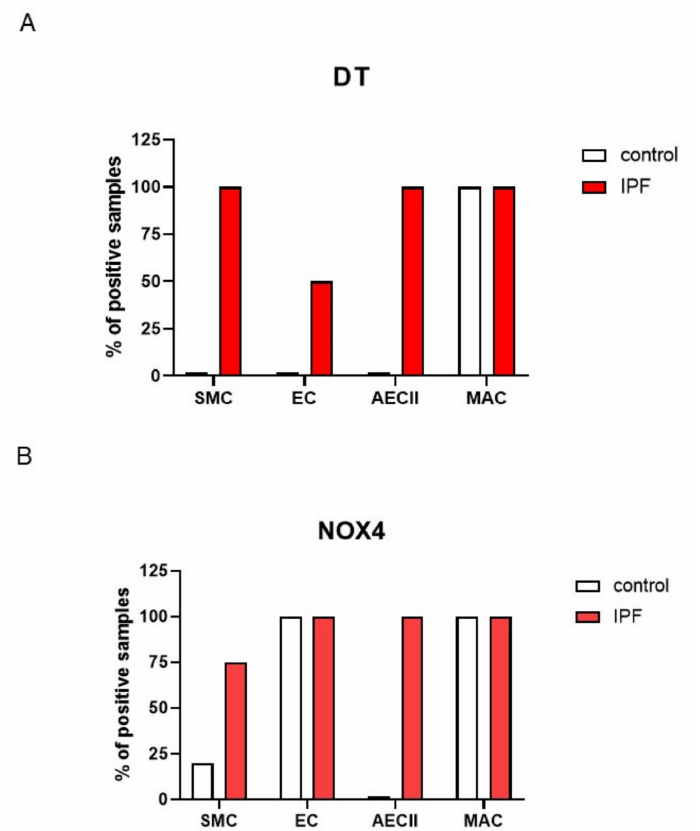
Figure 6. Histograms documenting the number of samples positive for DT and NOX4 for each cellular subtype. All 4 IPF patients were positive for DT in SMC and AECII while none of the controls showed DT staining ( A ). All cell types (SMC, AECII and EC were stained for NOX4 in IPF patients, while only EC were stained in the control ( B ). Macrophages were stained with both antibodies in both control and IPF (most likely not specific). SMC: smooth muscle cells, EC: endothelial cells, AECII: alveolar epithelial cells type 2, MAC